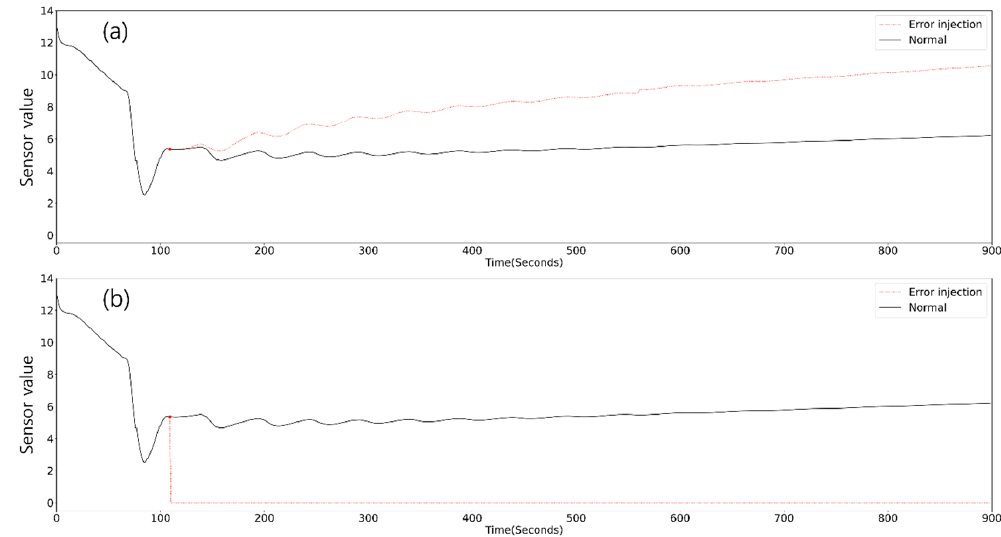
Figure 5. Example trends of ( a ) drift and ( b ) stuck at zero sensor errors.